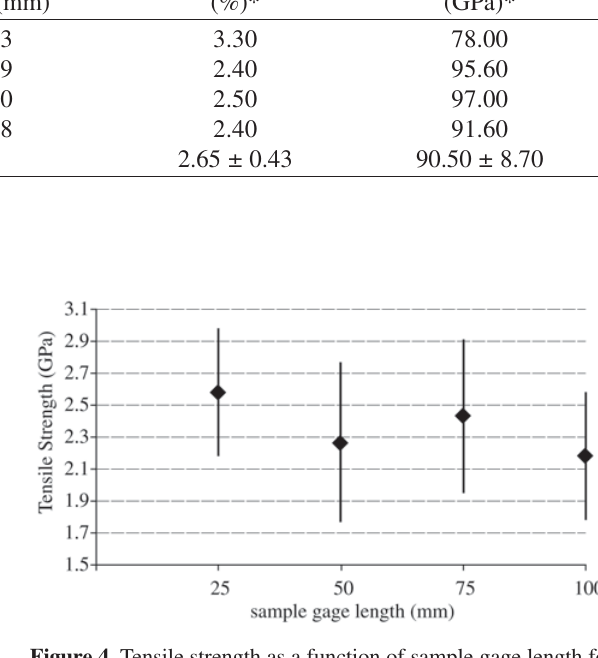
Figure 4. Tensile strength as a function of sample gage length for glass fibres.